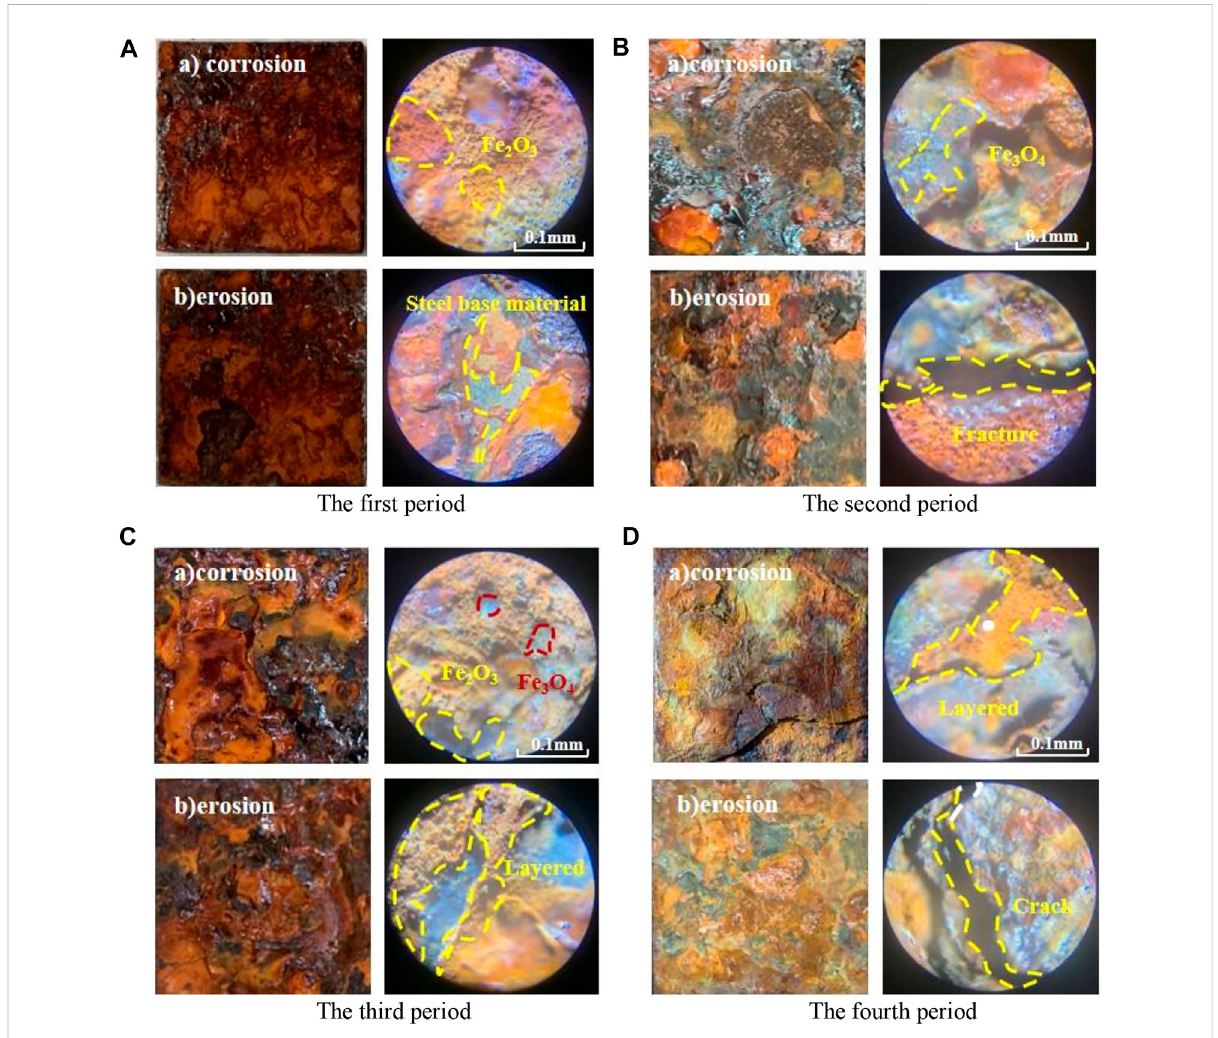
FIGURE 4 Damage morphology of steel samples under periodic water-sediment laden fl ow. (A) The fi rst period. (B) The second period. (C) The third period. (D) The fourth